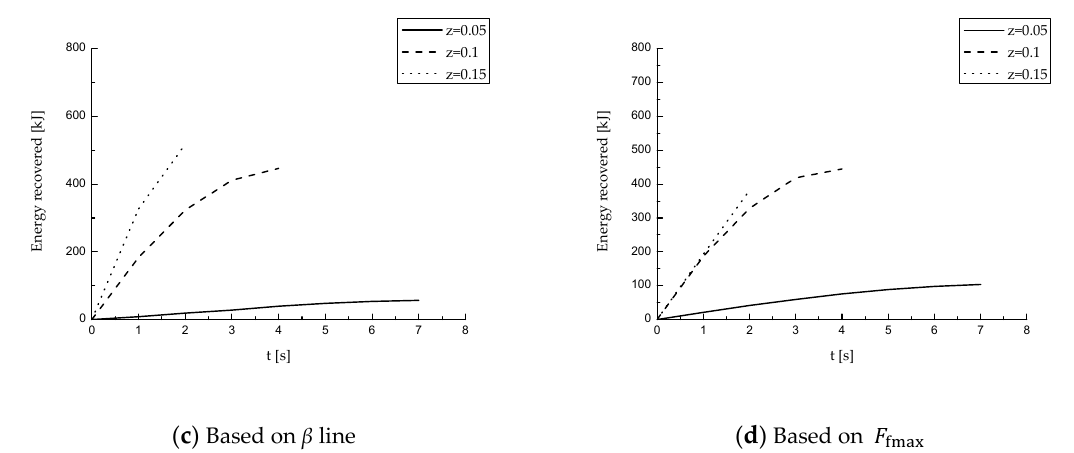
Figure 9. Different strategies recover energy at full load. ( a ) Based on vehicle speed; ( b ) based on I curve; ( c ) based on β line; ( d ) based on 𝐹 (cid:2916)(cid:2923)(cid:2911)(cid:2934) .